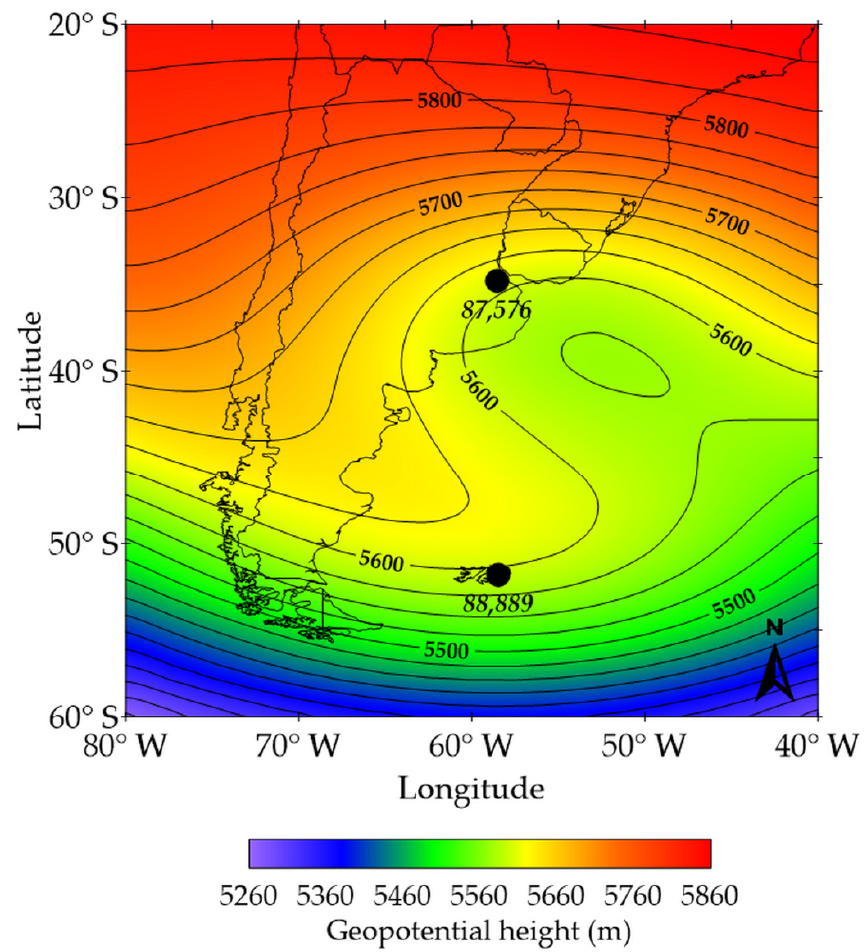
Figure 7. Composite of the 500 hPa fields in SSA, including the 74 dates on which there was at least an RBI. The black dots show the location of the upper-air stations used in the calculation of the RBI. See text for further details.